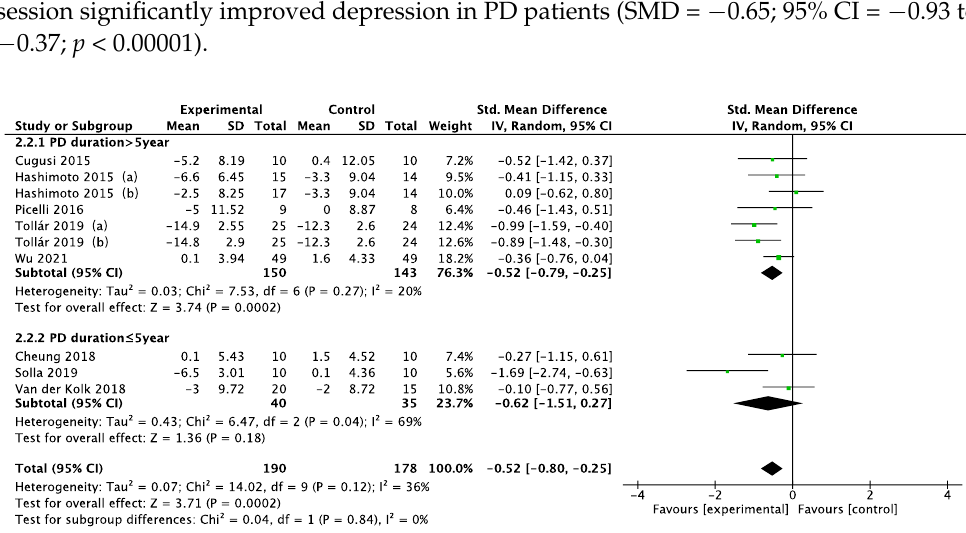
Figure 5. Subgroup analysis of disease duration [25,34 – 36,38 – 41].